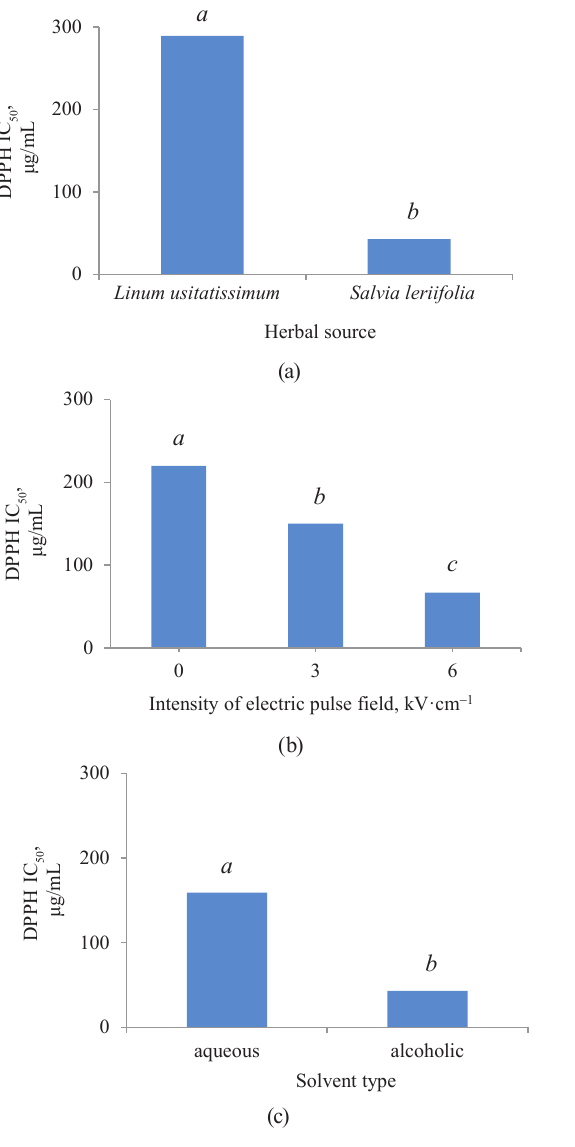
Figure 3 Independent effects of herbal source (a), pre- treatment (b), and solvent type (c) on antioxidant activity by DPPH method ( P ˂